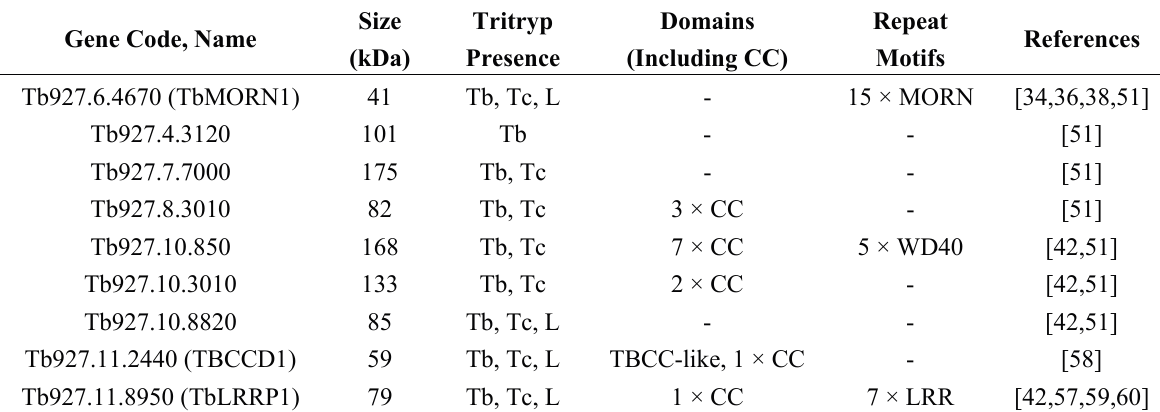
Table 1. Components of the hook